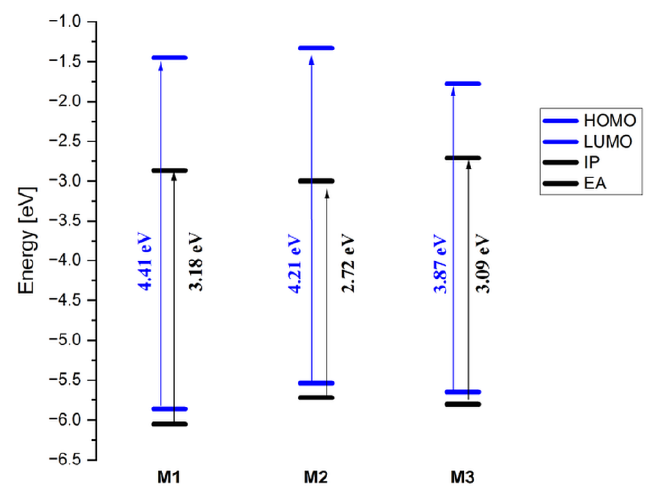
Figure 2. Molecular orbital energy level graph of M1 − M3 .